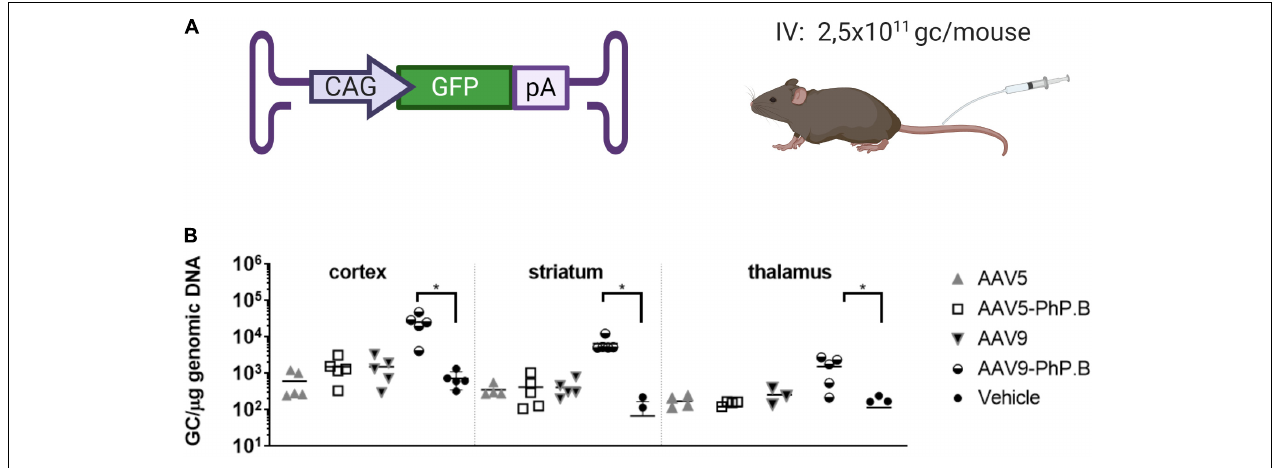
FIGURE 2 | Vector distribution in brain regions of AAV-PhP.B-GFP-administered mice. (A) Mice ( n = 5) were administered 2.5 × 10 11 GC/mouse by intravenous (IV) injection. The expression cassette used contained the CAG, GFP, and poly(A) tail. (B) Tissue was collected 6 weeks after surgery and analyzed for the distribution of the vectors. Significantly more vector DNA was retrieved from the cortex, striatum, and thalamus of AAV-PhP.B-GFP-administered mice when compared to vehicle (PBS). The statistical analysis was performed by a one-way ANOVA followed by the Tukey’s multiple comparisons test, comparing groups with vehicle. Asterisks indicate a statistical significance of p ≤